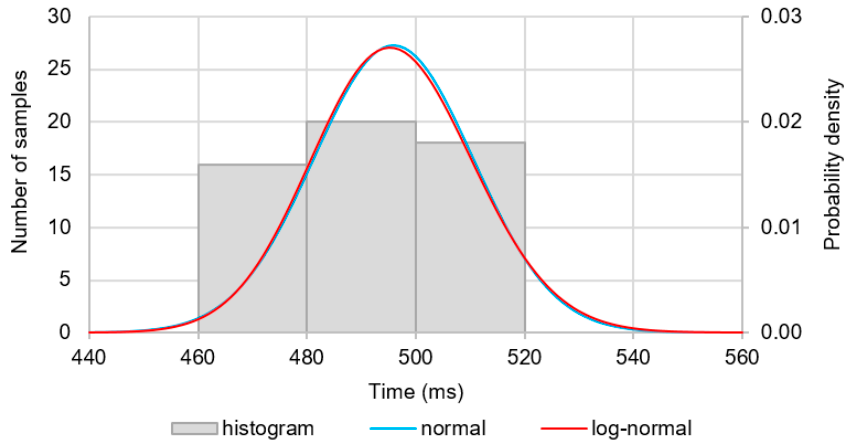
Figure 8. Histogram and the normal and log-normal operating time distributions for 7SA protection with 500 ms setting.